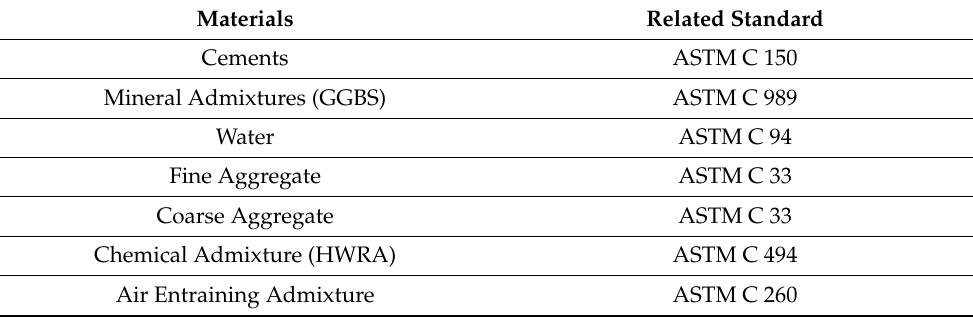
Table 1. Concrete Materials and Standards [30–35].